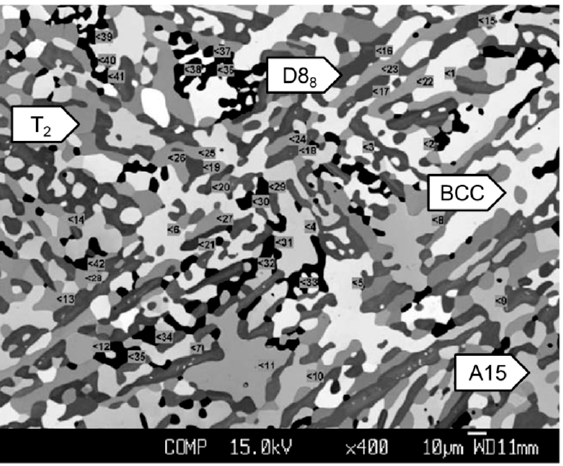
Figure 7. BSE image of the microstructure of the Mo–12.5Si–8.5B–27.5Ti (at.%) alloy after annealing at 1600 °C for 150 h, showing BCC (bright), A15 (gray), T 2 (darker gray) and D8 8 (black) phases [42]. Contrary to the thermodynamic predictions as stated in Section 3.1, the desired T 1 phase appeared in neither of the alloys [43]. Instead, a small amount of the D8 8 phase was observed in both of them. The reason for the discrepancy between the calculation and the experimental results has not been clarified yet, but the strong thermal stability of the D8 8 phase may give it the chance to form in the alloys. It should be mentioned that as predicted by thermodynamic calculation, the high solubility of Ti in every phase was observed, which led to a density reduction of nearly 18% as compared with the reference Mo–Si–B alloy [44]. The density reduction is one of the most attractive advantages for the macroalloying of Ti over other BCC stabilizers [23].